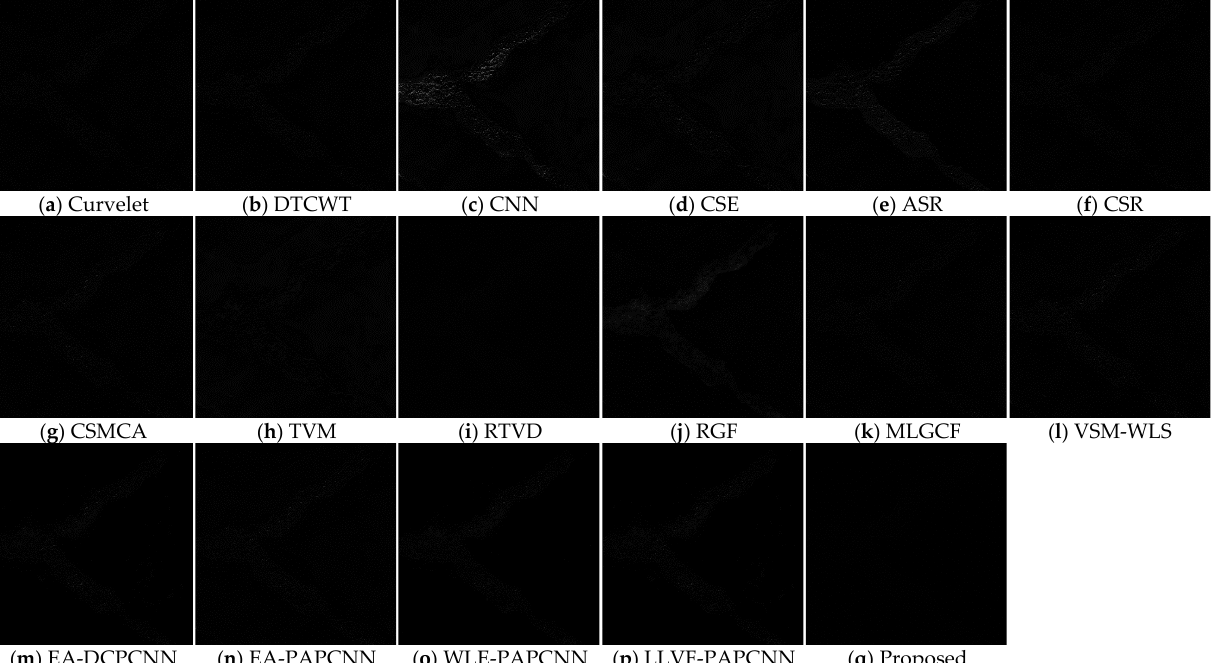
distortion, and the color of vegetation and shallow water is brighter. The proposed method can clearly show the details of water shoreline and pond edge, and the overall color of water body and vegetation is not significantly different from the original multi- spectral image. The overall colors of Curvelet, DTCWT, RGF, MLGCF, VSM-WLS, EA- DCPCNN, and EA-PAPCNN fusion methods are slightly brighter, whereas the overall Figure 10. Error images corresponding to WorldView-2 images. color of WLE-PAPCNN is slightly darker. Figure 10. Error images corresponding to WorldView-2 images. Figure 11 presents the fusion results of WorldView-3 images, and Figure 12 shows the corresponding SAM error images. It shows that TVM, RTVD, ASR, CSR, and CSMCA fusion methods have poor retention ability of spatial information, and the water edge is blurred. The two fusion methods of CNN and CSE have different degrees of spectral